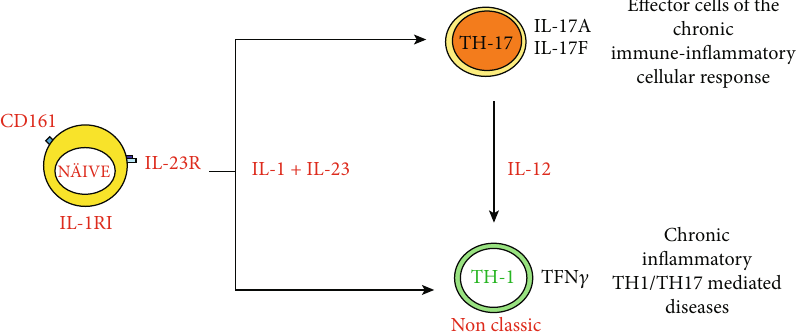
Figure 4: IL-1 and IL23 induce CD4 CD161 precursors ’ di ff erentiation to classical Th-17 and Th-1 cells in the presence of IL-12. IL-1: interleukin-1; IL-23: interleukin-23; IL-12: interleukin-12; Th: T-helper